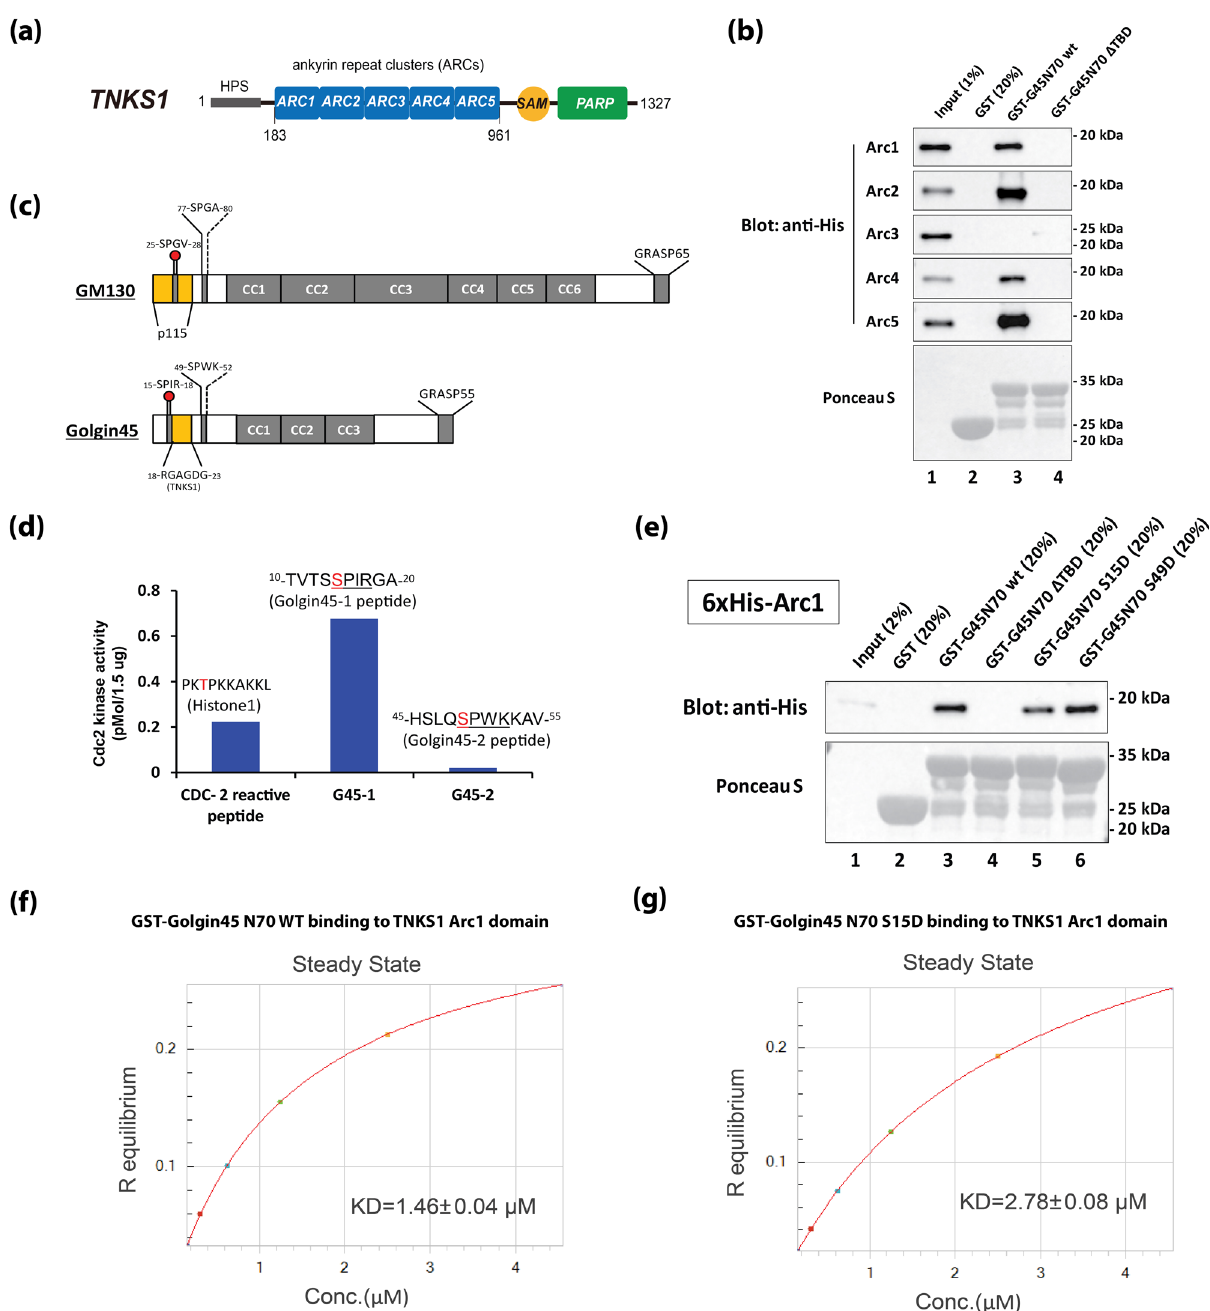
(Fig. 3b), indicating that TNKS1 contains at least four binding sites for Golgin45 Ankyrin repeat